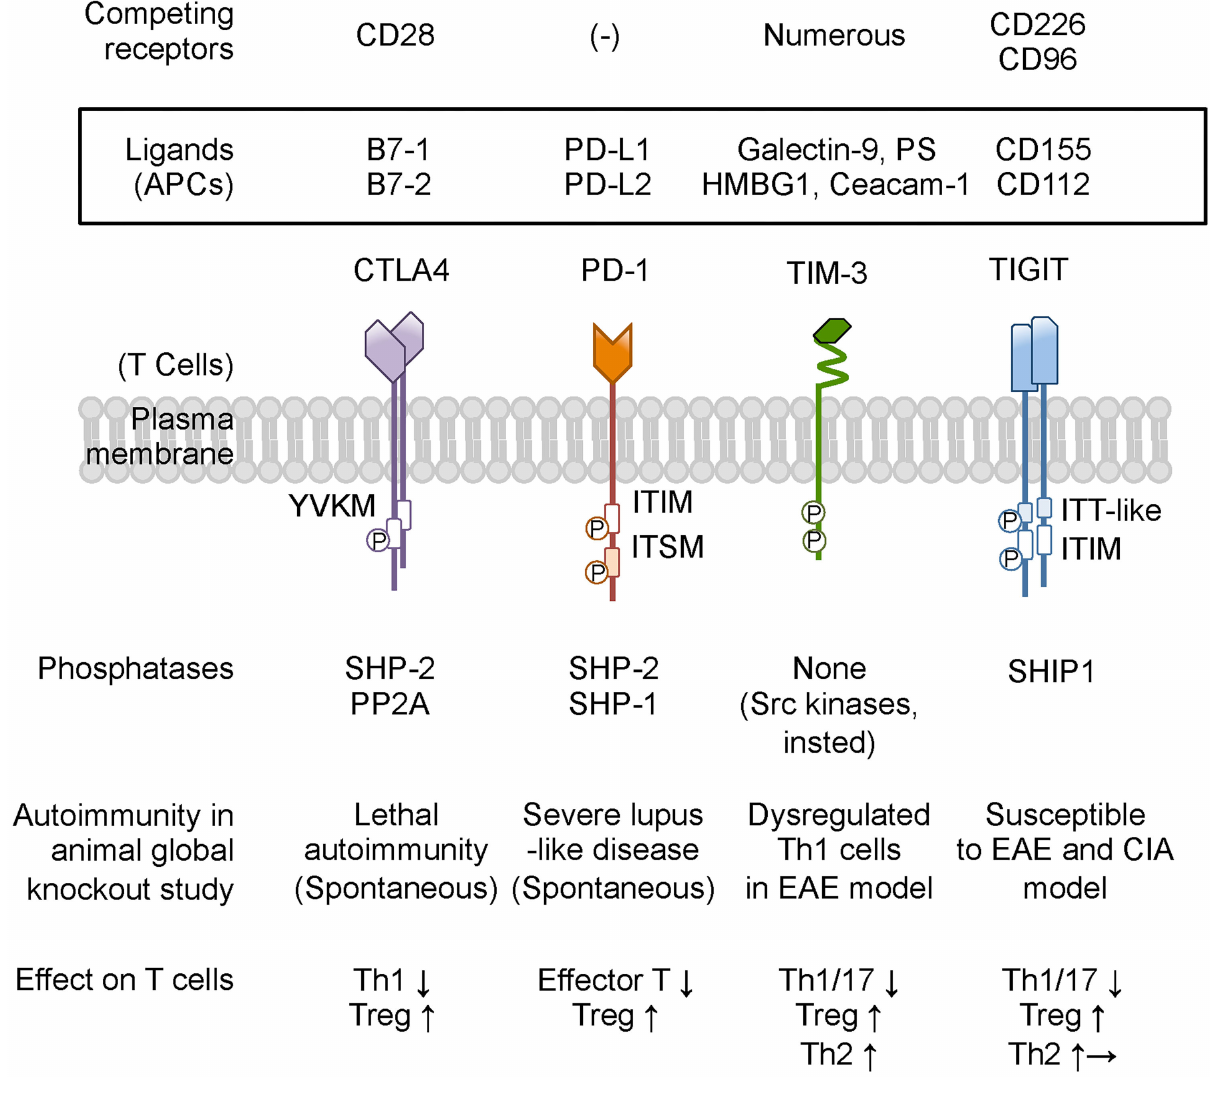
FIGURE 2 | Co-inhibitory receptors on T cells and ligands, phosphatase, and modulation of T-cell function. Co-inhibitory receptors have a variety of physiological and pathological ligands, and the binding is occasionally competed by other immune receptors on T cells. TIM-3 does not have a classical signaling motif in its cytoplasmic tail. However, the cytoplasmic domain of TIM-3 contains tyrosine residues to be targets for phosphorylation and promoting TIM-3-mediated T-cell inhibition by allowing binding of SH2 domain-containing Src kinases. Based on animal studies, CTLA4 and PD-1 are predicted to be associated with more susceptibility to autoimmune disease, while neither TIM-3-deficient nor TIGIT-deficient mice present any spontaneous autoimmune disease phenotype. Co-inhibitory receptors on T cells commonly suppress effector T-cell functions by down-modulating Th1 cells and Th17 cells and by enhancing Treg cells. In addition, TIM-3 and TIGIT shift the cytokine balance to Th2 immunity. PS, phosphatidyl serine; HMGB1, high-mobility group protein B1; Ceacam-1, carcinoembryonic antigen-related cell adhesion molecule 1; PP2A, protein phosphatase 2A; EAE, experimental autoimmune encephalomyelitis; CIA, collagen-induced arthritis. Other abbreviations are shown in Figure 1